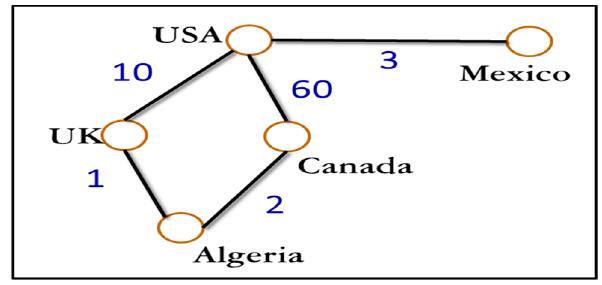
Figure 3. Example of a valued graph (i.e., edges have values).